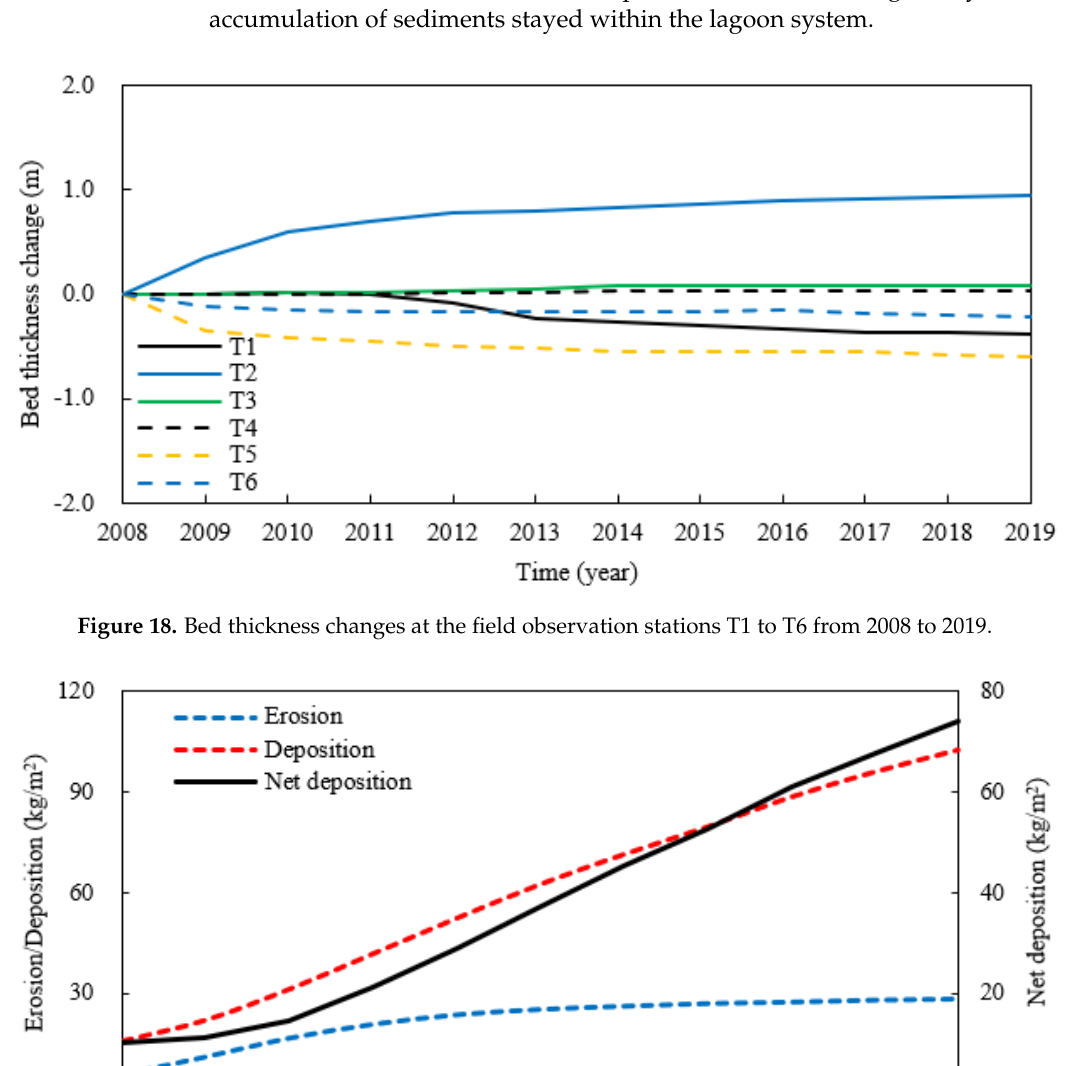
Figure 18. Bed thickness changes at the field observation stations T1 to T6 from 2008 to 2019.